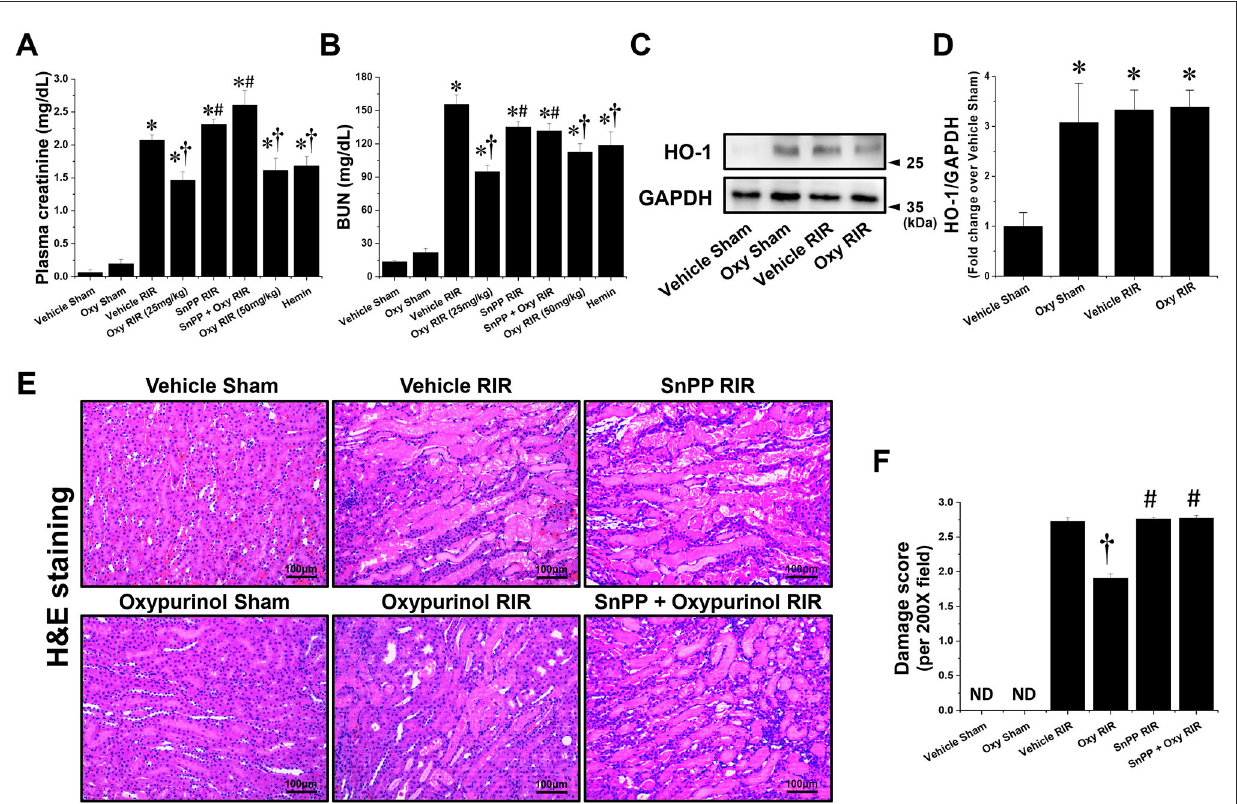
FIGURE1 Oxypurinol protects against renal ischemia/reperfusion injury via heme oxygenase-1 (HO-1) induction. C57BL/6 male mice were subjected to sham or 30min of renal ischemia surgeries. Some mice were pretreated with 25 or 50 mg/kg of oxypurinol at 24h and 1h preoperatively. To test whether HO-1 induction is critical for oxypurinol-mediated renal protection against renal I/R injury, we injected an HO-1 inhibitor [25 mg/kg, tin protoporphyrin IX (SnPP)] before oxypurinol first treatment. Some mice were pretreated with 25 mg/kg of hemin at 24 hours preoperatively. (A, B) Twenty-four hours after surgeries, plasma creatinine (PCr) and blood urea nitrogen (BUN) levels were measured. (C) Kidney samples were subjected to Western blotting using an anti-HO-1 antibody. GAPDH was used as a loading control. (D) Band intensities were measured using ImageJ. (E) Representative images (magnification, 200 × ) of kidney sections subjected to hematoxylin and eosin (H&E) are shown. (F) Histological damages were analyzed as described in the Materials and Methods section. Results are expressed as means ± standard errors of the mean (SEM) (vehicle or oxypurinol [oxy] sham n = 4; vehicle, oxypurinol, SnPP, or SnPP + oxypurinol renal ischemia/reperfusion (RIR) n = 6). * P < 0.05 vs. vehicle sham; † P < 0.05 vs. vehicle RIR; # P < 0.05 vs. oxypurinol